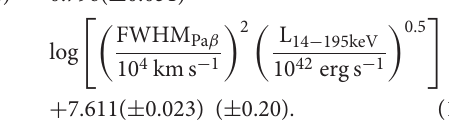
lines show significant broad components, with FWHM